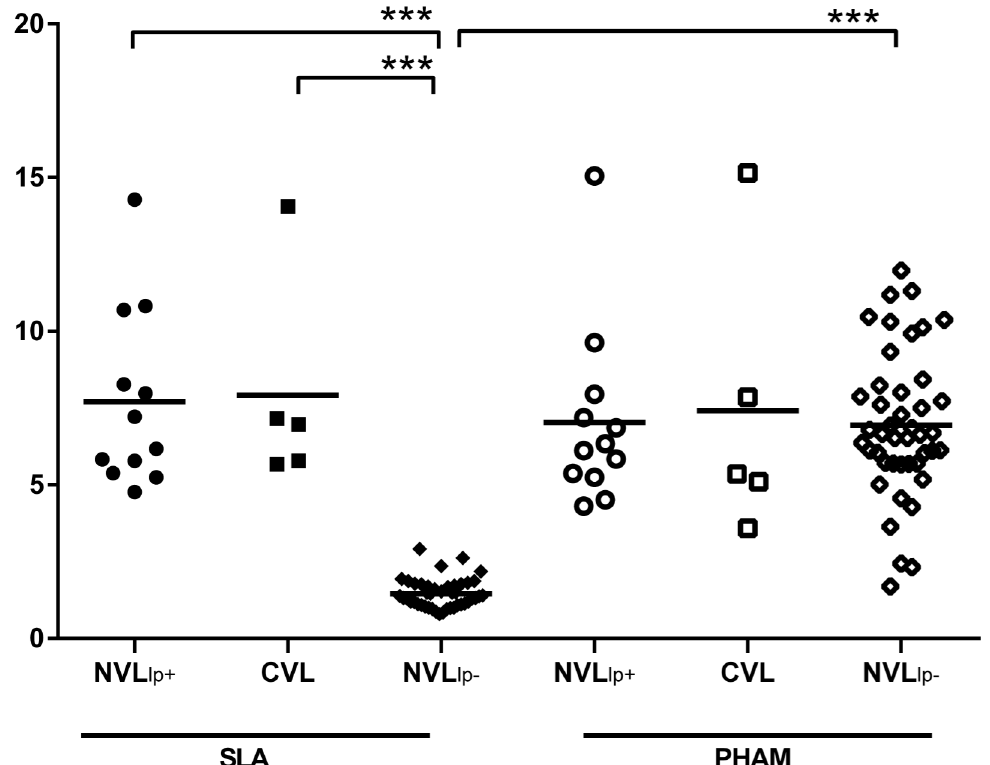
Fig 1. Lymphoproliferative response to SLA of PBMCs from solid organ (SOT) recipients — 57 with no previous history of leishmaniasis (NVL) and 5 cured SOT recipients (CVL). NVL SOT recipients were then classified as either positive (NVL lp+ ) or negative (NVL lp- ). *** p < 0.001.